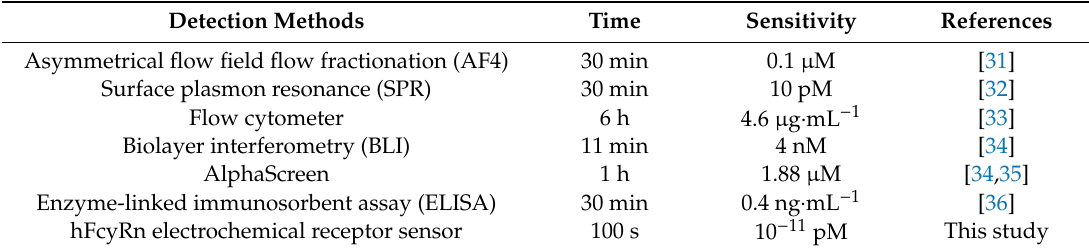
Table 3. The detection method of interaction between IgG or Fc fusion protein and Fc γ